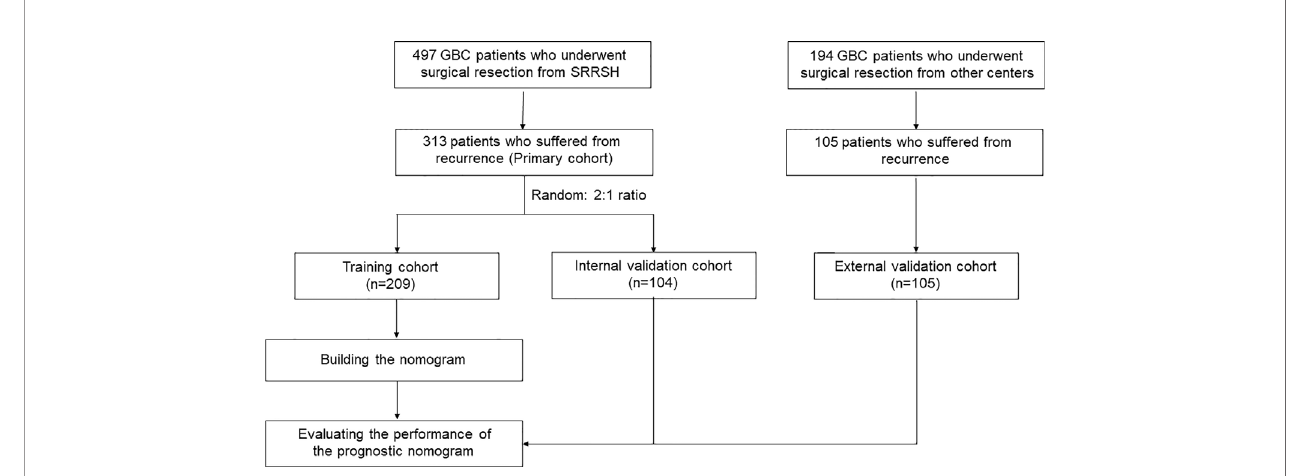
FIGURE 1 | Flowchart of population selection and study